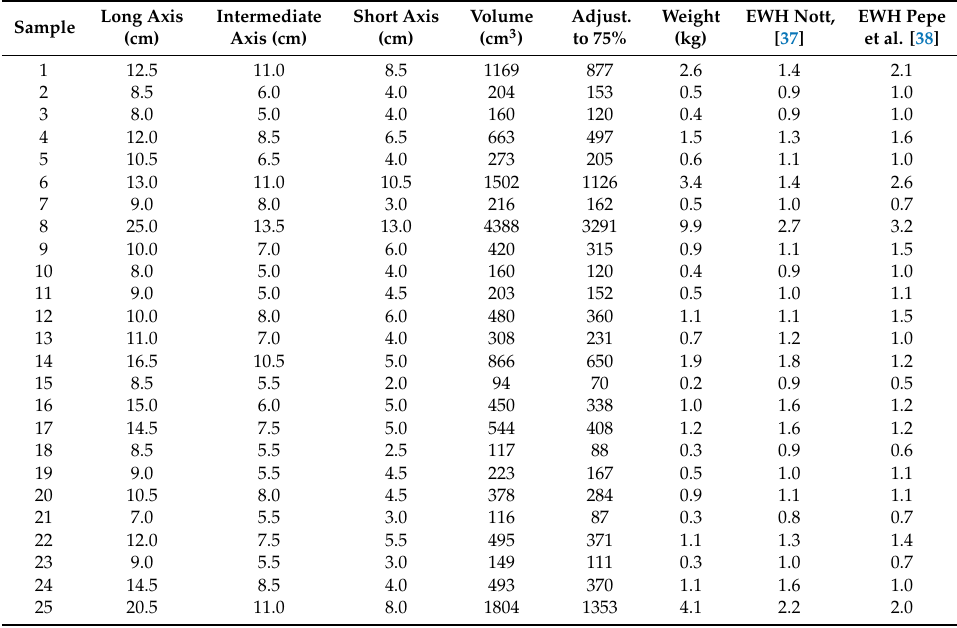
Table 2. Quantification of boulder size, volume, and estimated weight from the Pleistocene (MIS 5e, Marine Isotope Substage 5e) coastal conglomerate at site 2 at Prainha, on the southern coast of Santa Maria Island (see Figure 1b). The standard density of basalt at 3.0 gm / cm 3 was applied uniformly in order to calculate wave height for each boulder. EWH: estimated wave height (in meters), calculated according to equations from Nott [37] and Pepe et al. [38]. See the methods Section 3.2. (hydraulic model). Long Axis Sample